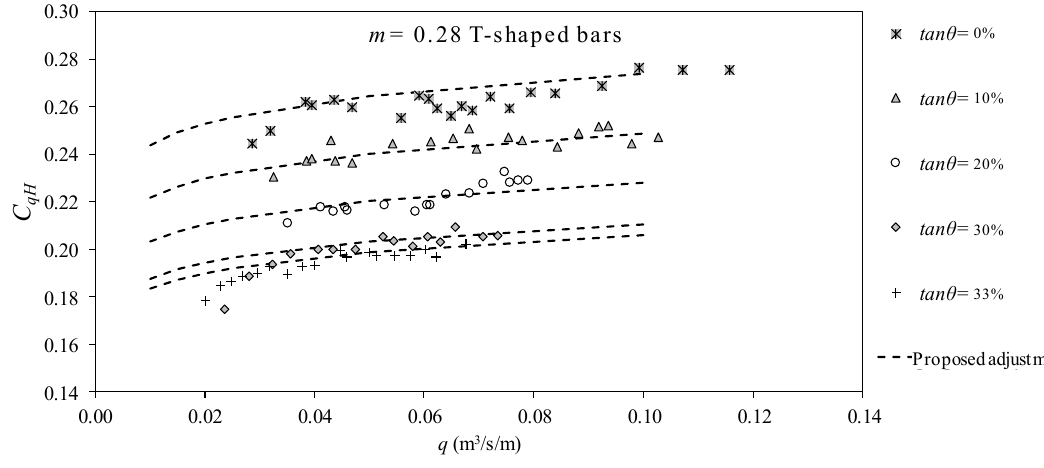
Figure 25. Mean discharge coefficient C qH as a function of the incoming flow q , for T-shaped flat bars